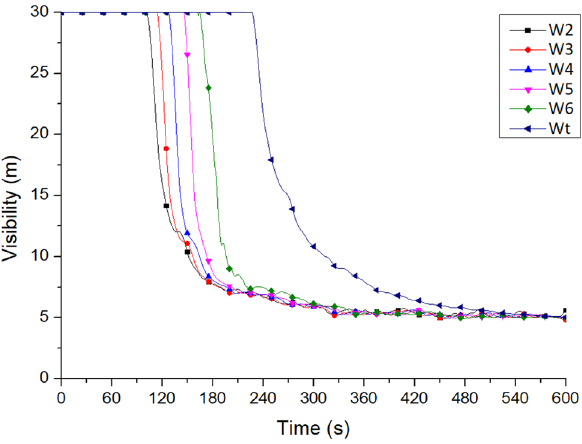
Figure 14. Visibility variation at the platform windows on each floor of No. 2 staircase (for Case